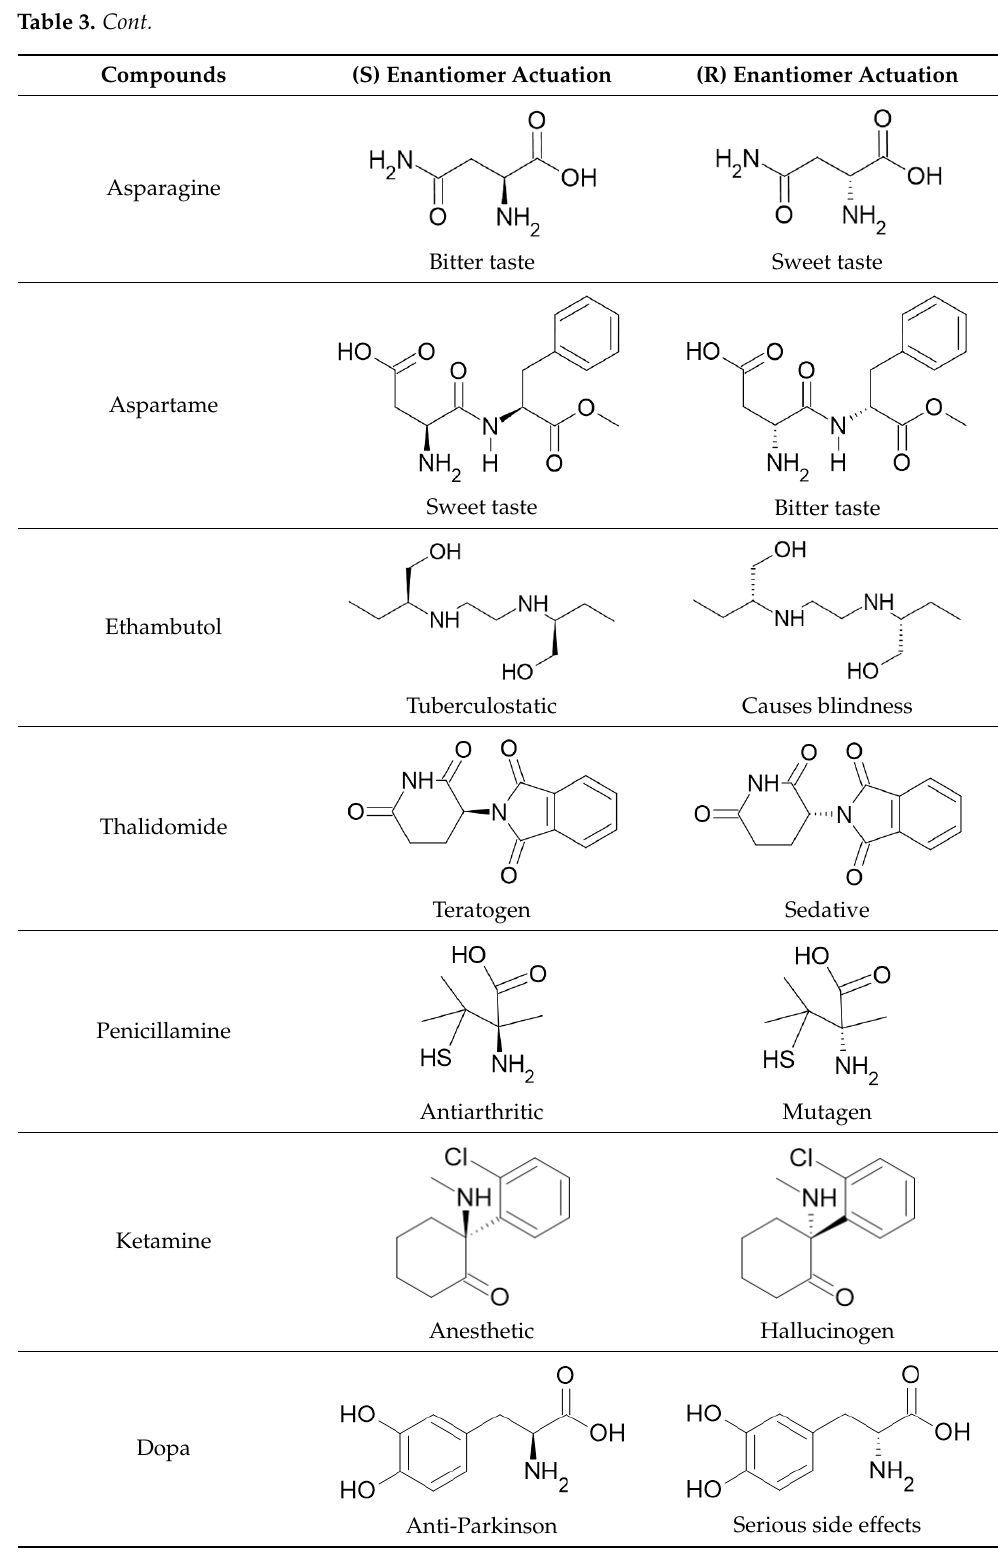
8 Figure 6. Deoxyribose ( a ) and ribose ( b ) monosaccharides structural formulas from DNA and RNA and their chiral carbons. Table 3. Difference in biological activities between enantiomers [4]. Compounds